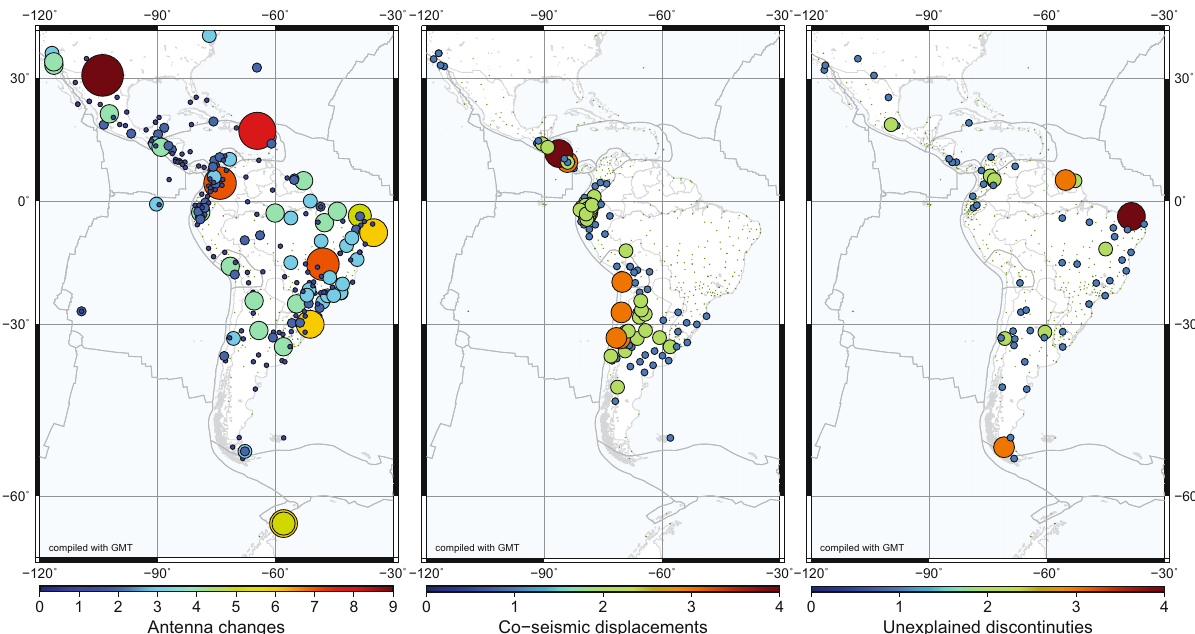
Figure 16: Time series discontinuities detected in SIRGAS2022: 68.7% are caused by antenna changes ( left ) , 20.9% correspond to co - seismic displacements ( centre ) , and 10.4% have unexplained causes ( right )